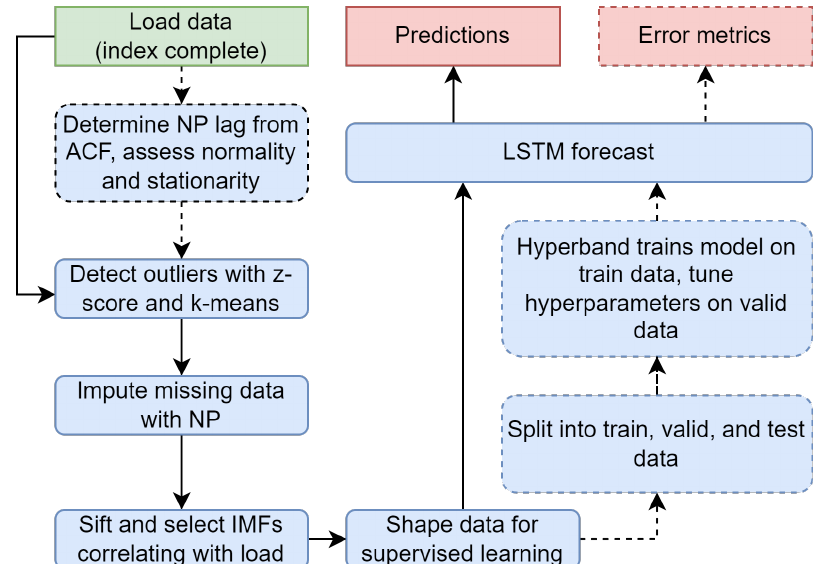
Figure 1. A simplified process diagram of the long short-term memory (LSTM) methodology begins with the input cumulative raw data and ends at the output of predicted load values and error metrics. For a new dataset, all blocks are included and dashed lines are prioritized over solid ones, such that naive persistence (NP) lag and the autocorrelation function (ACF) are only established once. The dashed lines and blocks are omitted after data have been pre-processed and the model has been hyperparameter optimized, such as during an operational